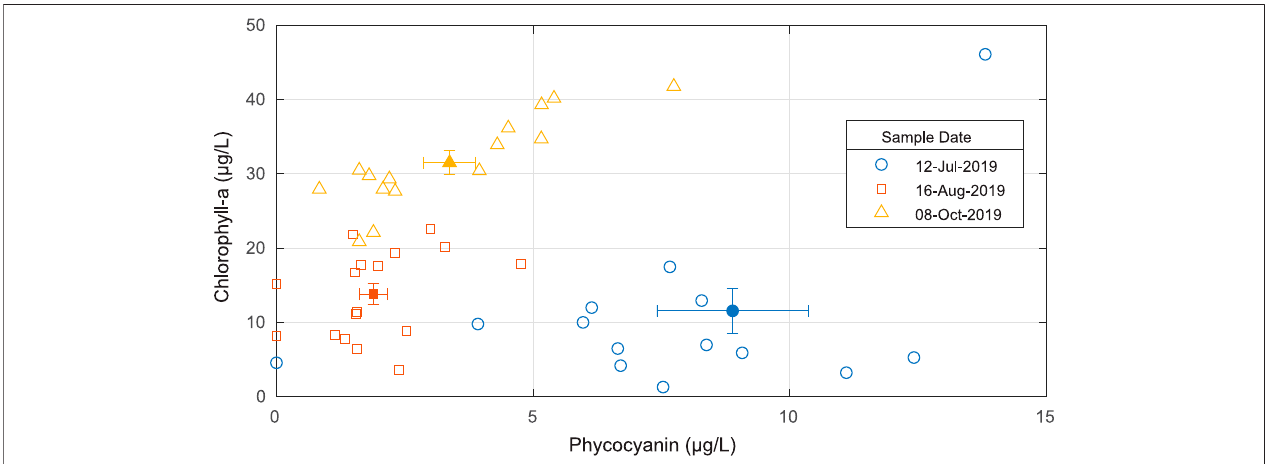
FIGURE 2 | Phycocyanin and chlorophyll- a concentrations in discrete samples collected on July 12, 2019, August 16, 2019, and October 08, 2019. The July 12, 2019 sampling event observed a higher average phycocyanin to chlorophyll- a ratio compared to the other sampling dates. The averages for each sampling date are shown as the solid symbols with the vertical error bars representing the standard error of the chlorophyll- a measurements and the horizontal error bars representing the standarderrorofthephycocyaninmeasurements.Thereisanoutlier(phycocyanin (cid:2) 25.6 μ g/Landchlorophyll- a (cid:2) 27.2 μ g/L)fromJuly12,2019thatisnotshown in this plot for visualization